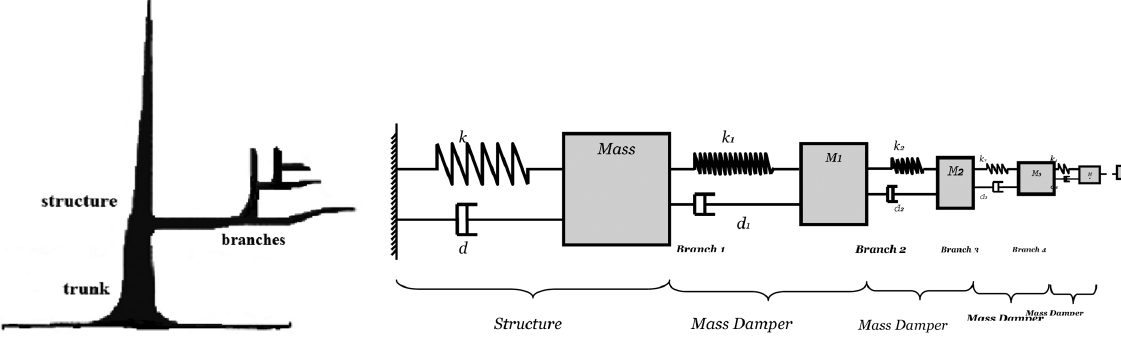
Fig. 2. Complex branching of a tree and equivalent mass-damping